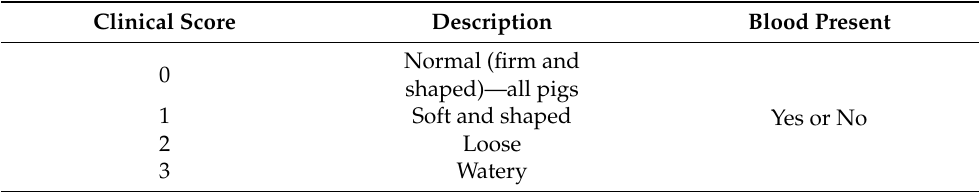
Table 5. Fecal score categorization of pigs used to test core antigen bacterin with an immunostimulant on health and performance outcomes when challenged with enteric and respiratory pathogens.